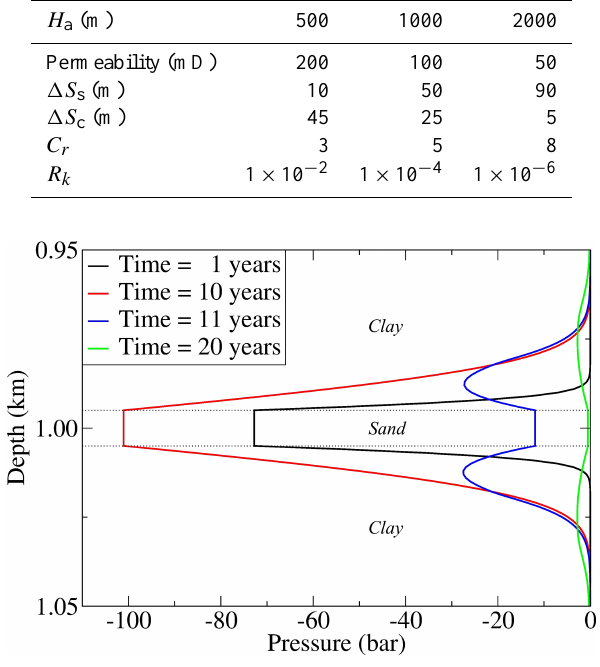
Figure 2. Pressure change predicted by the groundwater flow model along the symmetrical axis in the case with H a = 1000m, (cid:49)S c = 45m, R k = 1 × 10 − 6 and C r =